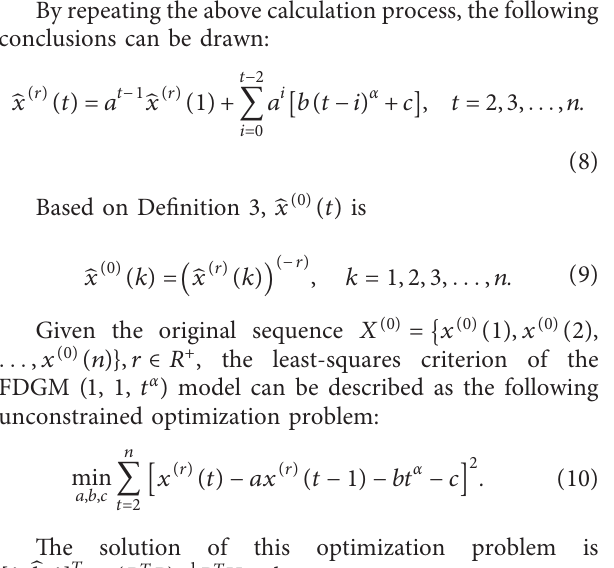
into other grey